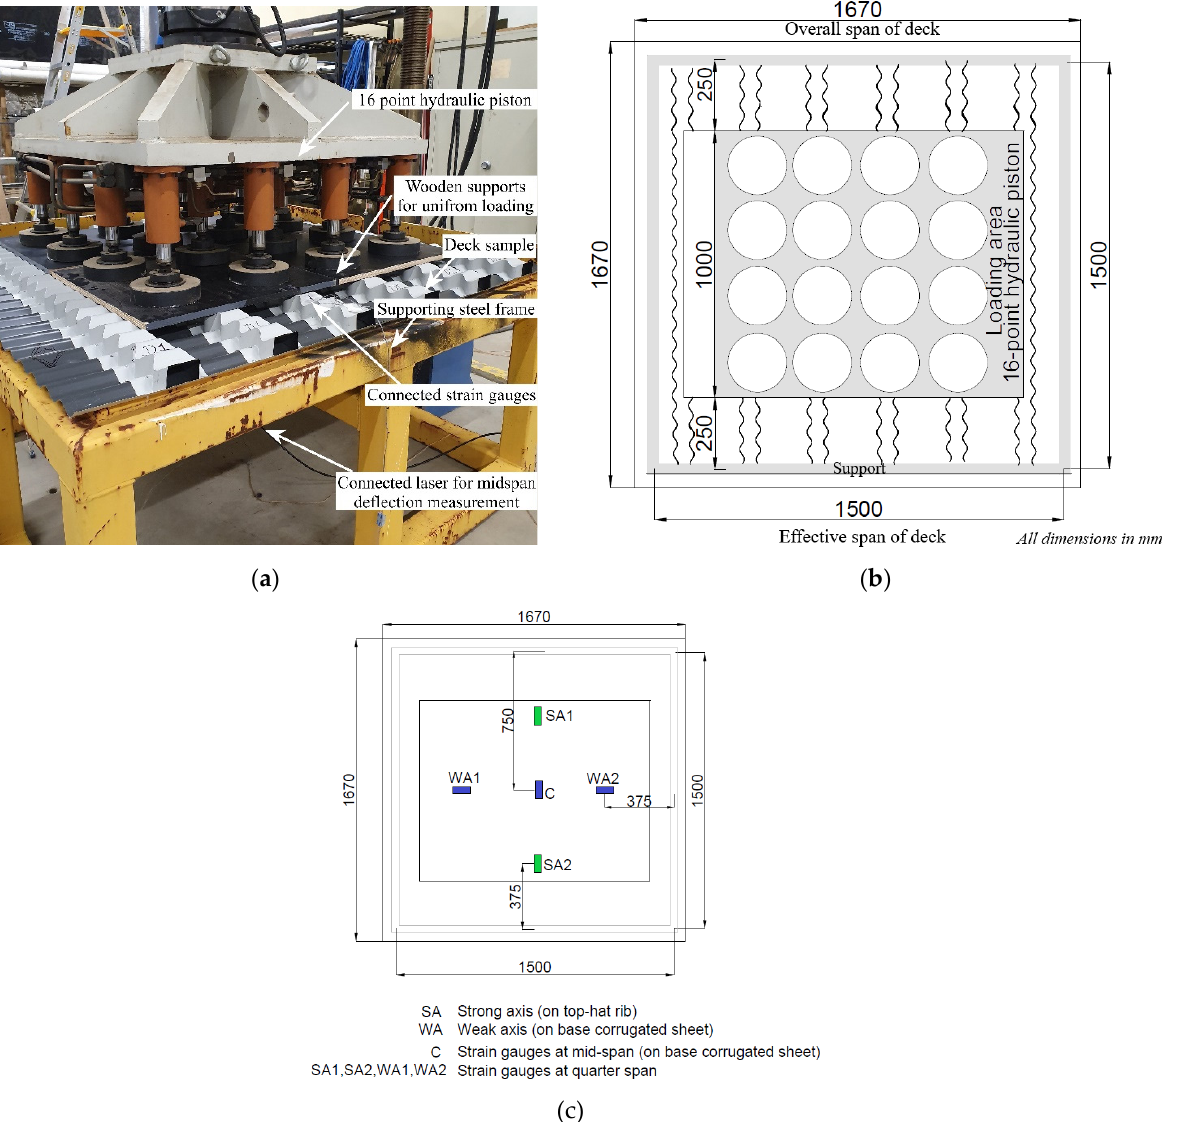
Figure 2. Test setup. ( a ) Experimental setup and loading. ( b ) Schematic of the test setup. ( c ) Strain gauge positions.